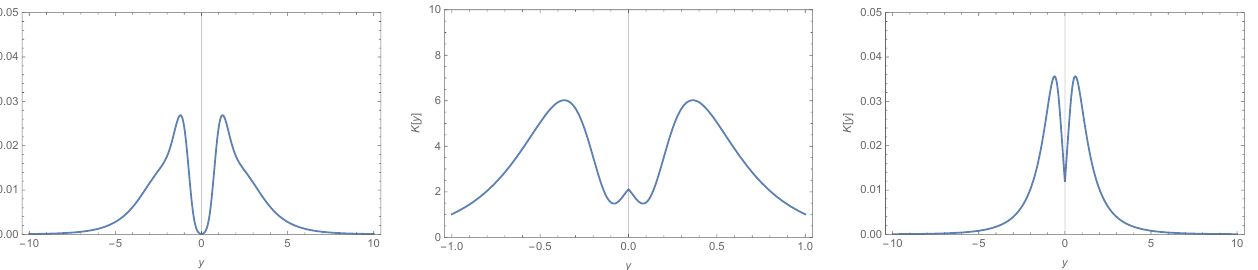
Figure A3. Plot of the Kretschmann scalar for the first, second, and third WH solution (Equations (85), (89) and (92), respectively). The value of the parameters for each case is the same as in the plots of Figures 4–6,